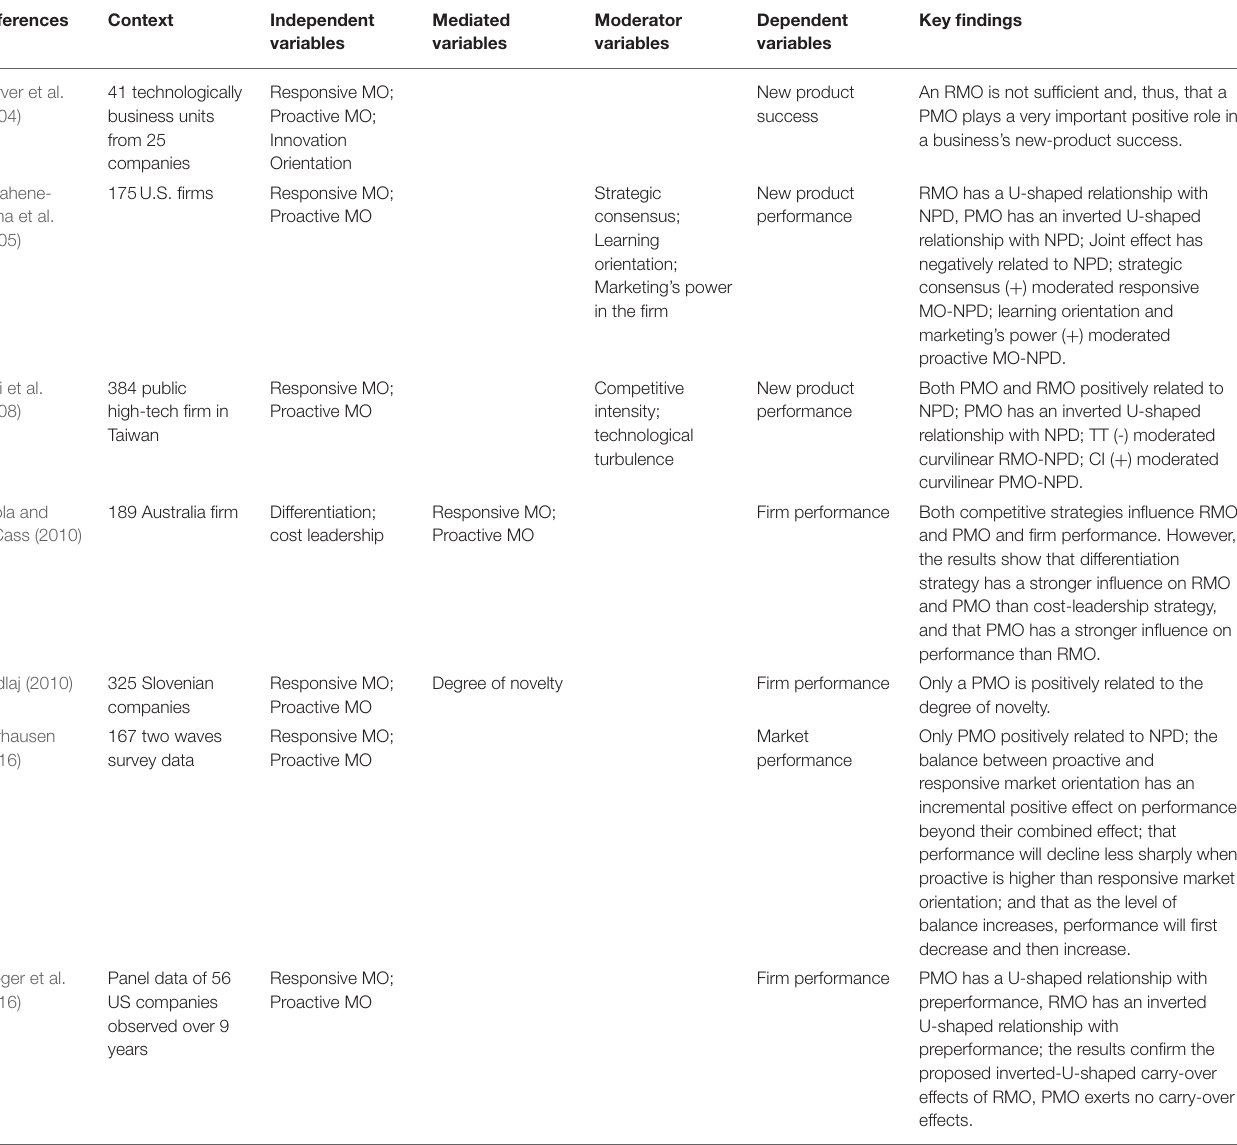
TABLE 1 | A chronological review of the literature on responsive market orientation and proactive market